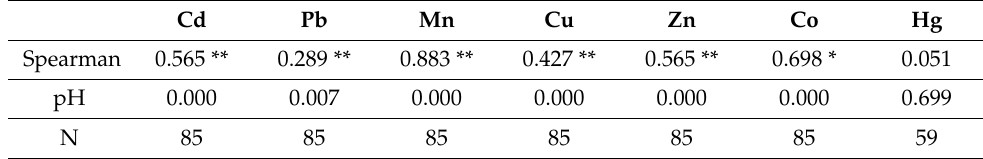
Table 3. Correlation analysis of PTEs concentrations between total and bioavailable